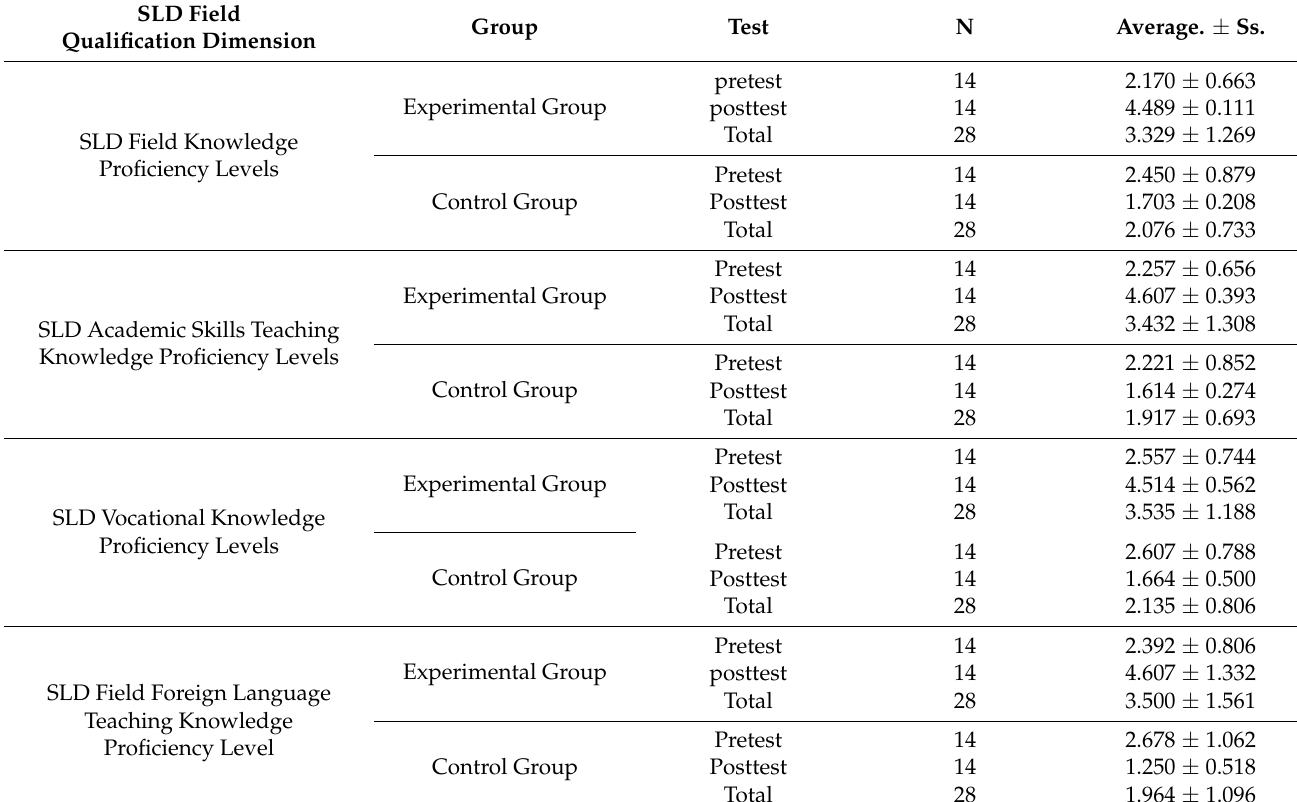
Table 4. The average scores of the participants’ proficiency levels in SLD.